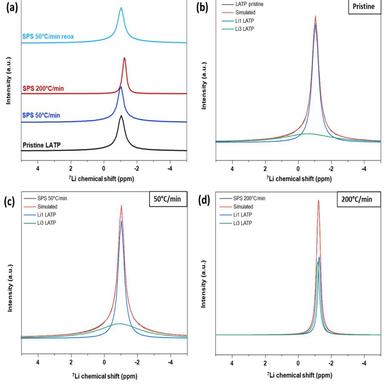
7 Li NMR spectra of the pristine powder LATP, samples sintered by SPS at 50 ◦C/min, before and after re-oxidation, and at 200 ◦C/min (a). Deconvolution of each spectrum: pristine (b), SPS 50 ◦C/min (c) and SPS 200◦/min (d). The experimental and simulated spectra are displayed as black and red lines respectively. The simulated spectrum is the sum of distinct line shapes displayed as blue and green lines.